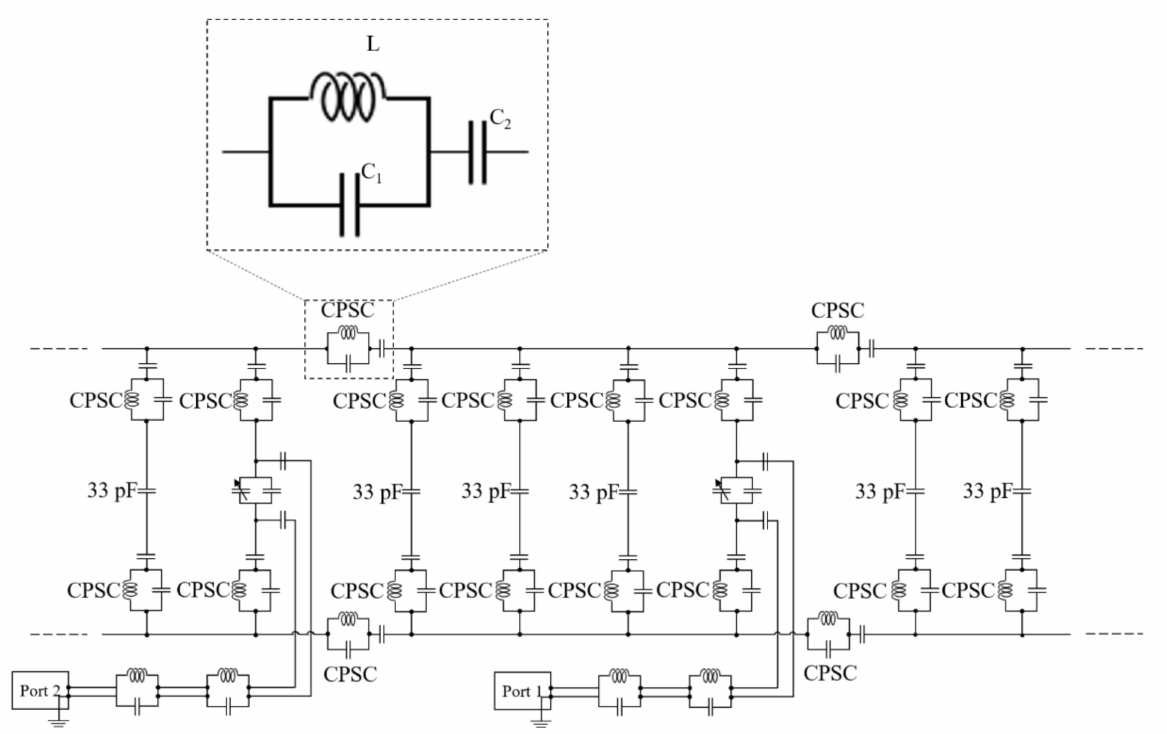
Figure 1. Circuit diagram of the 16-leg PFT 13 C low-pass birdcage RF coil containing 40 carbon-proton switching circuits (CPSCs). Trimmer capacitors with high Q-factors are connected to ports 1 and 2 and used for fine-tuning of PFT 13 C birdcage RF coil. Only half of the coil circuitry is shown in the figure; the other eight legs with 20 CPSCs without RF feeding are omitted for